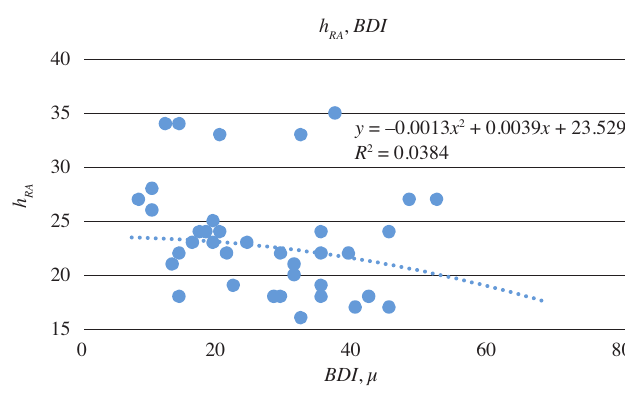
Figure 4. Relationship between thickness of RA layer and